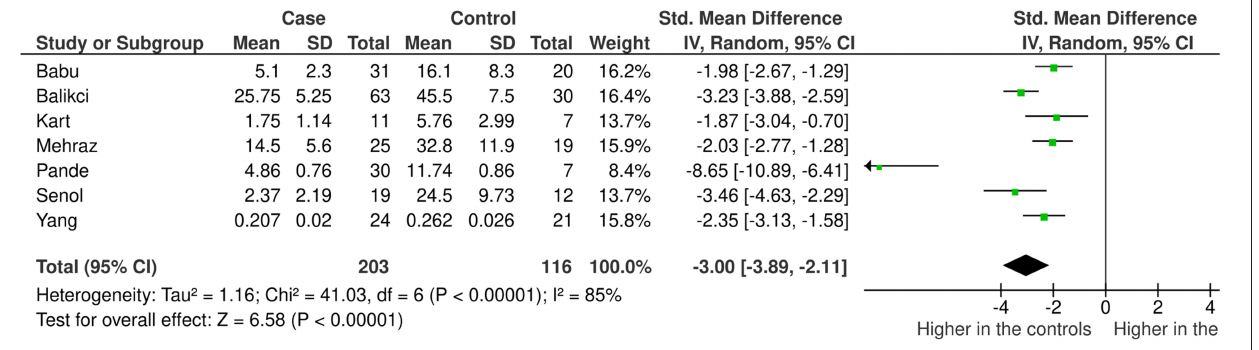
FIGURE 3 | The study characteristics and standardized mean differences of the density of the interstitial cells of Cajal like cells at the ureteropelvic junction in patients with ureteropelvic junction obstruction and matched